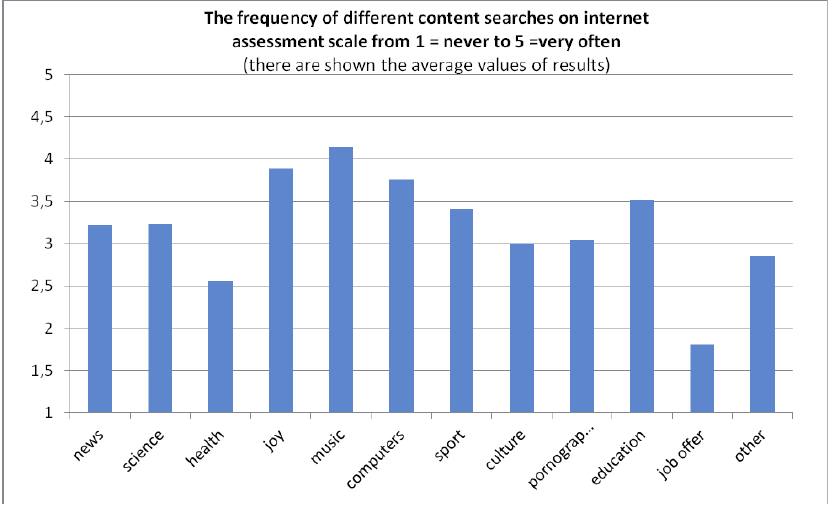
Fig. 5. The answers of survey participants regarding the search of certain contents online, in which education holds a very high place . Source: Own chart (Lajbenšperger, & Raji ć ,